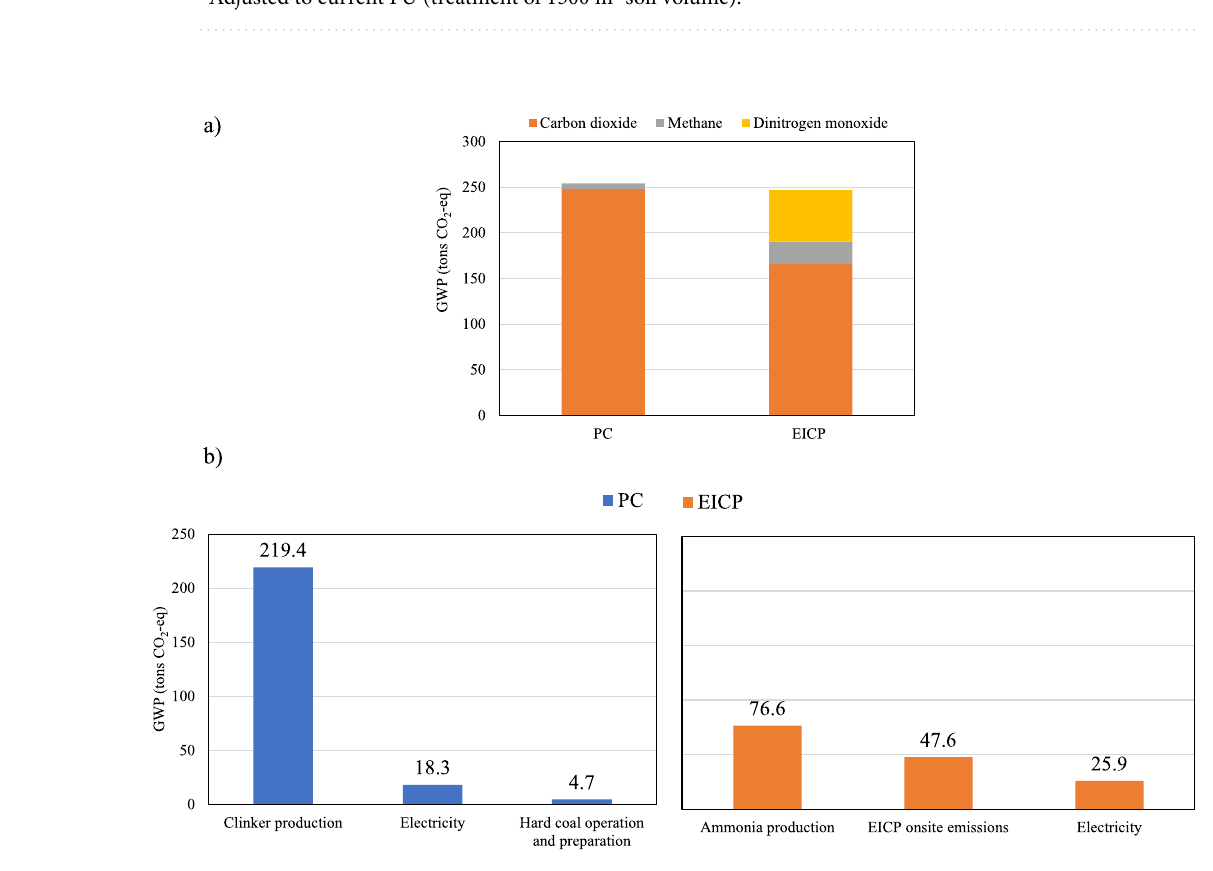
Figure 2. Global warming potential of the PC and EICP soil stabilization techniques: ( a ) total and individual emissions, and ( b ) highest contributing